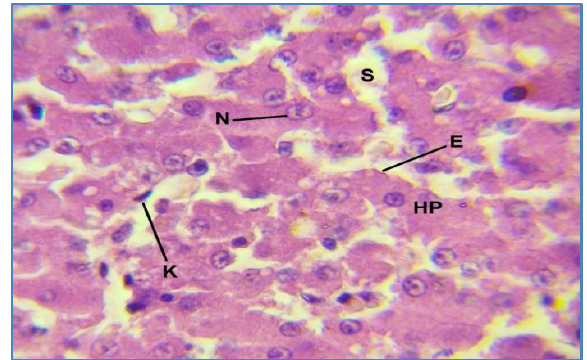
Figure, 11: Histological section of the liver in gull shows, the hepatocyte plates (HP), sinusoids (S).nucleus of hepatocyte (N), kupffer cell (K), endothelial cell of sinusoid (E) (H and E